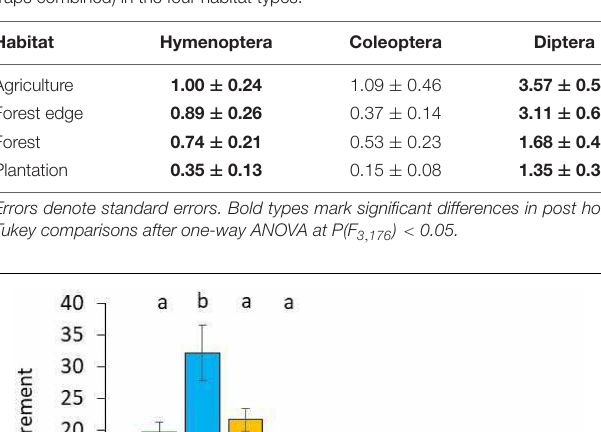
( Table 2 ). Pollination activity was lowest in places without